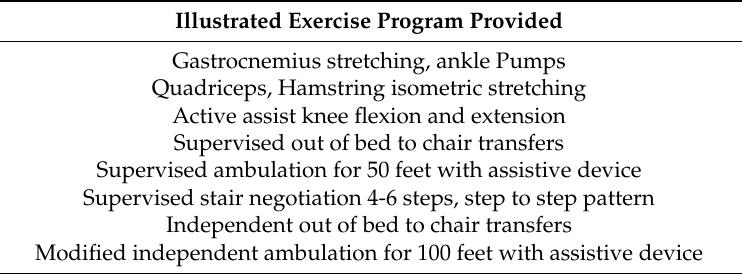
Table 1. Physical Therapy